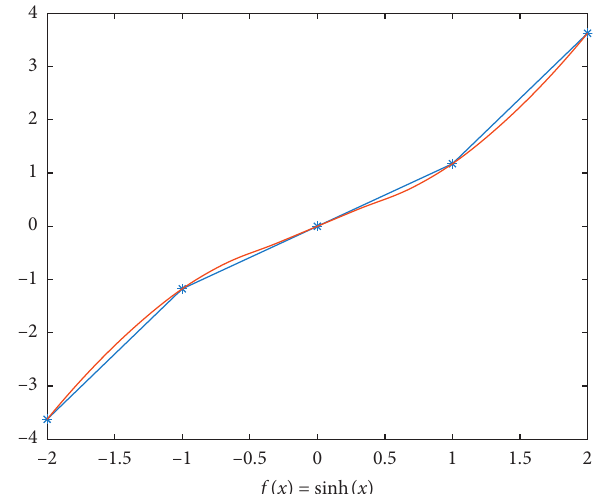
u � 1/12. The initial polygon derives from f ( x ) � x 2 k ⟶∞ k